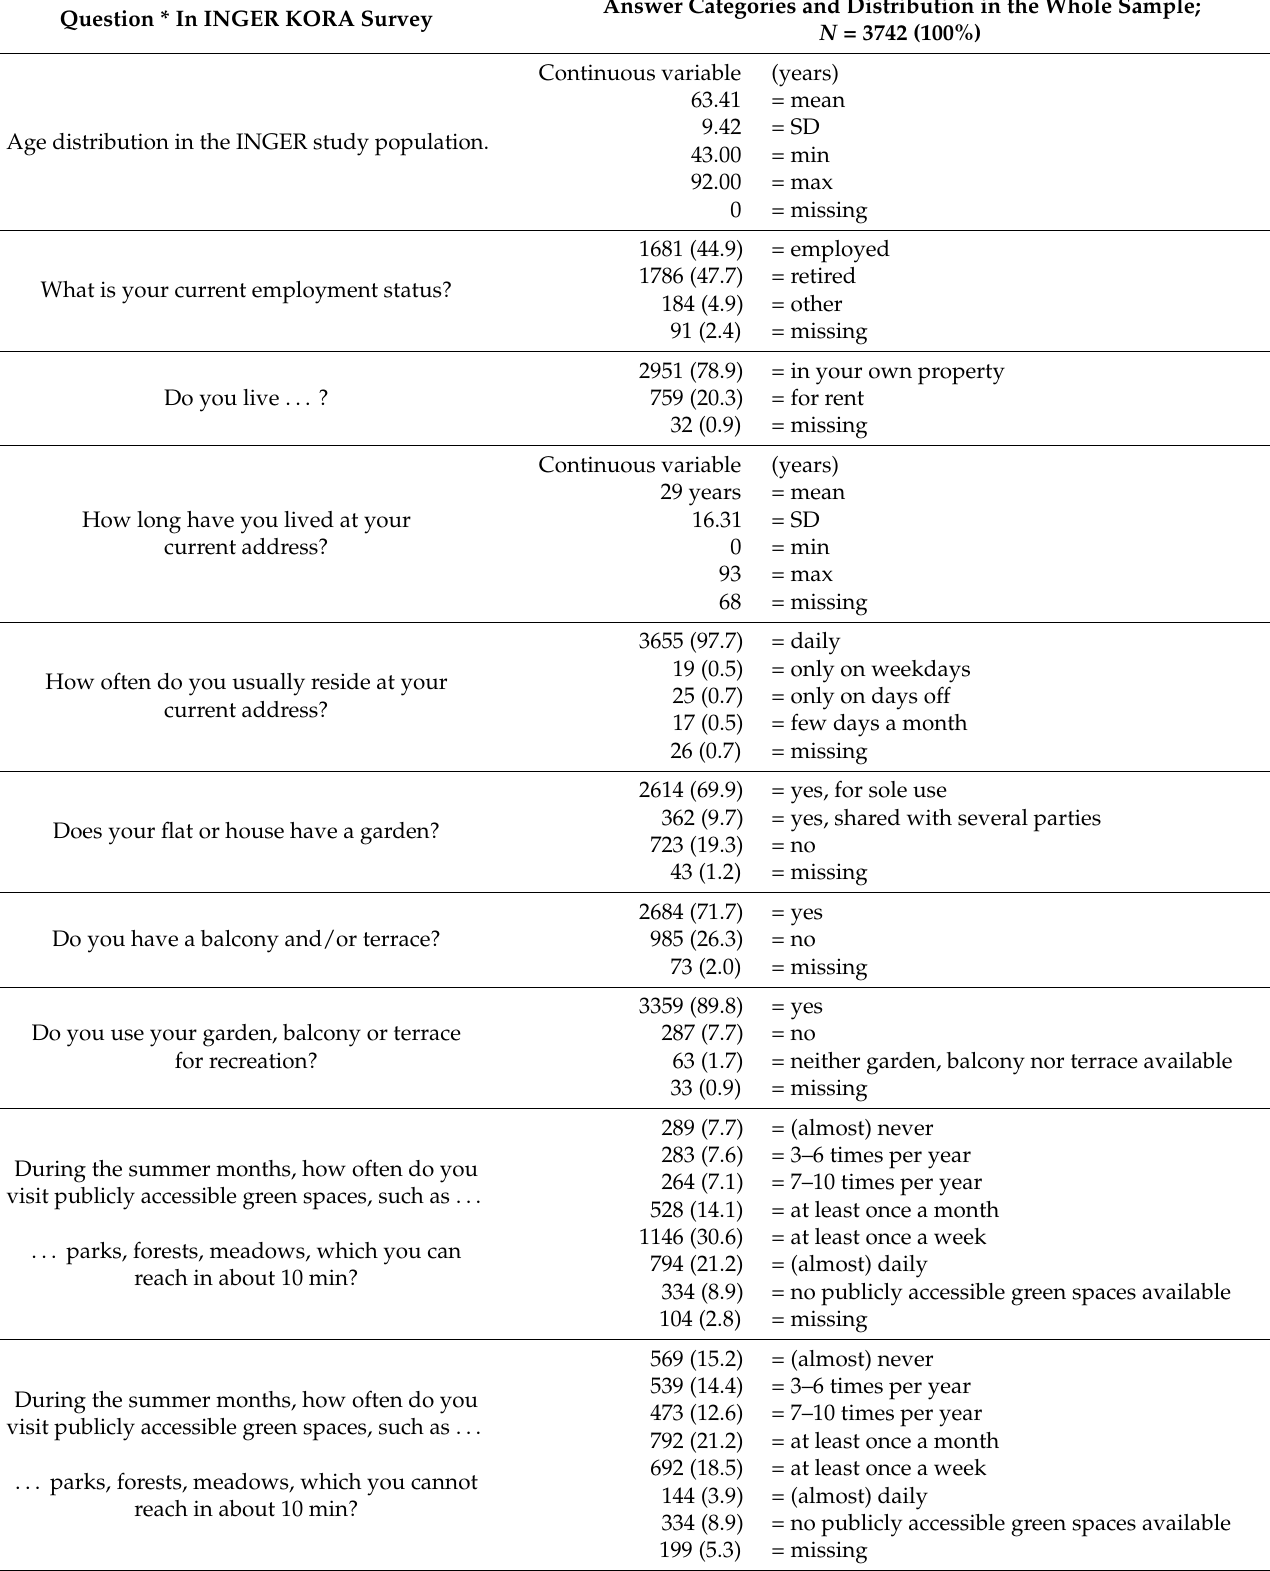
Table 3. Further description of the INGER study